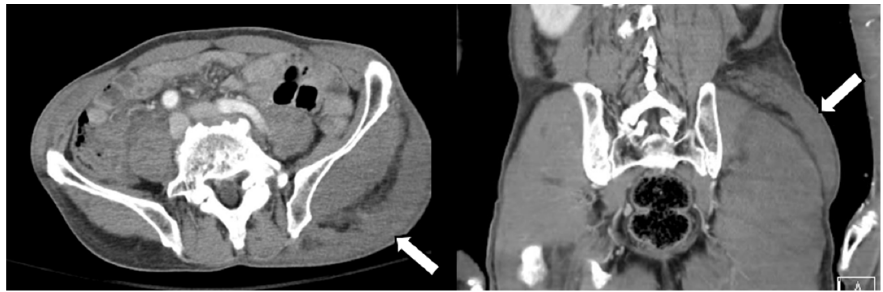
Figure 2. CT scans of the abdomen and pelvis showed an abnormal soft tissue lesion in the left buttock.